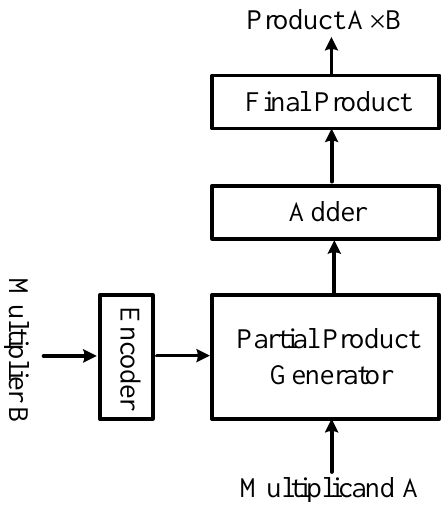
Figure 1. Conventional booth multiplier